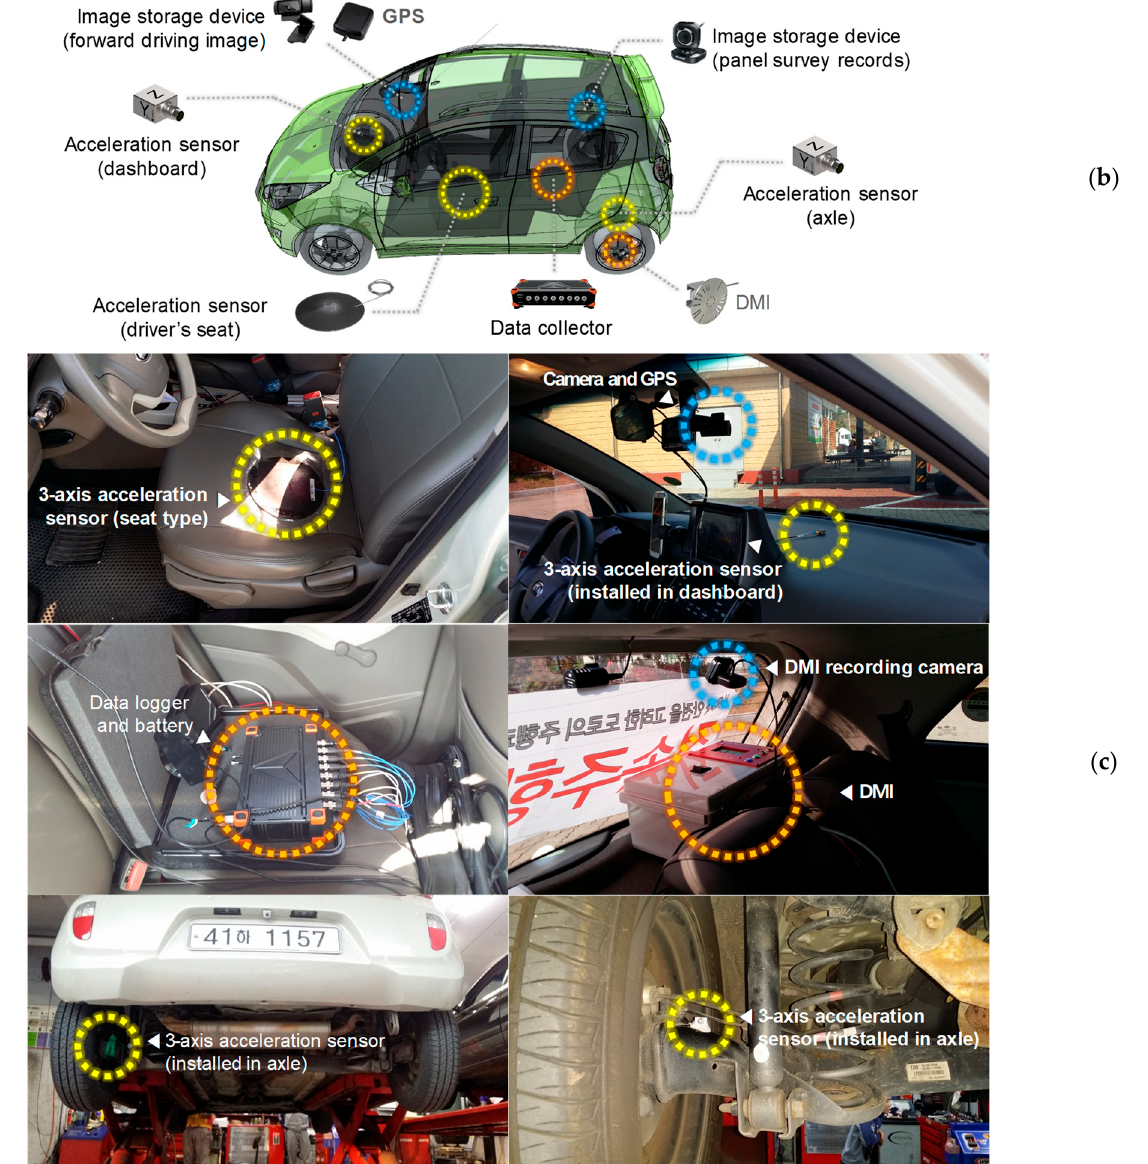
Figure 1. Evaluation system for lateral vibration. ( a ) Acceleration data collection direction. ( b ) Data- collection system. ( c ) Mounting of sensors.